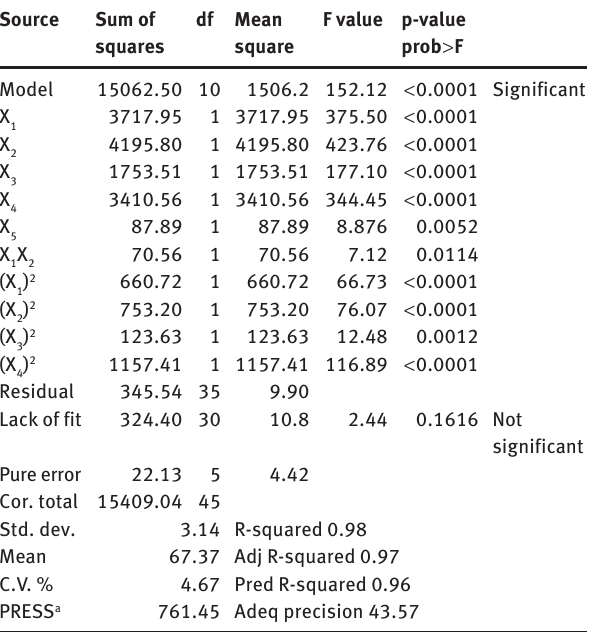
are significant, whereas the interaction effects could not show a considerable effect on the extraction efficiency. ANOVA results were presented graphically in Figures 3 A and 3B. A plot between the observed and pre- dicted response for all four chelating agents is shown in Figure 3 A. All of the points were equally scattered around the diagonal line, which demonstrate their low discrep- ancies. The predicted values of the extraction efficiency lie within ± 10% of the experimentally observed response. Good correlations between observed and predicted data with R 2 of 0.98, 0.97 and 0.97 were obtained for Ni extrac- tion using EDTA, DTPA and NTA, respectively. Residuals provide a clear picture for any discrep- ancies in fitting to the model and are important to test the assumption of constant variance [ 26 ]. Therefore, residuals vs. fitted plots were drawn for all four chelat- ing models, to determine the possibility of non-linear- ity and unequal error variances. The plot of internally studentized residuals vs. predicted values is presented in Figure 3 B for [S,S]-EDDS, EDTA, DTPA and NTA. The pattern shown in Figure 3 B indicates that residuals are randomly scattered around zero deviation, which vali- dates the assumption of linearity. All of the points lie in the acceptable range between -3 to 3, thus the existence of systematic errors may be cast